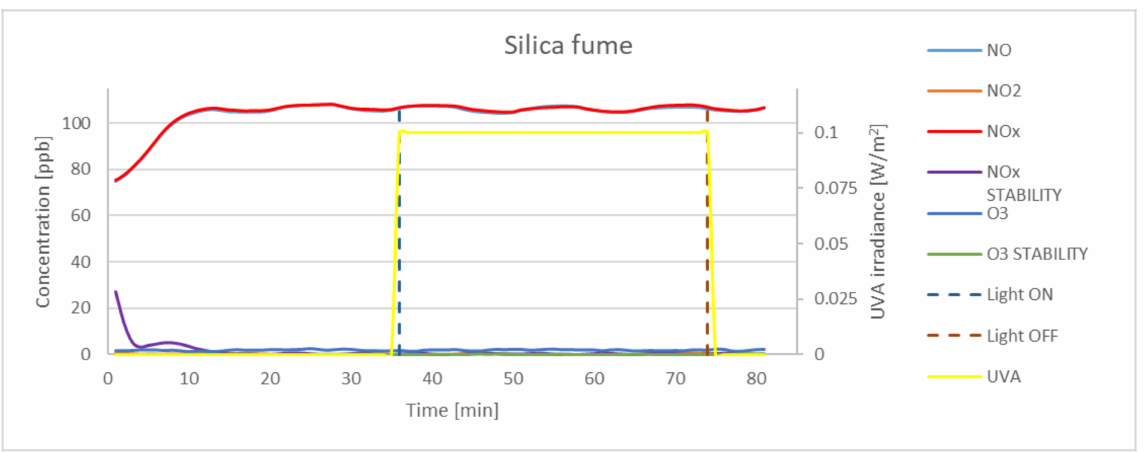
Figure 8. The oxidation of NO in the photocatalytic reaction with concentrations of NO 2 , NO x , and O 3 measured for silica fume. Data on UVA irradiation are shown in the supplementary chart. Dashed lines indicate the time of light on and